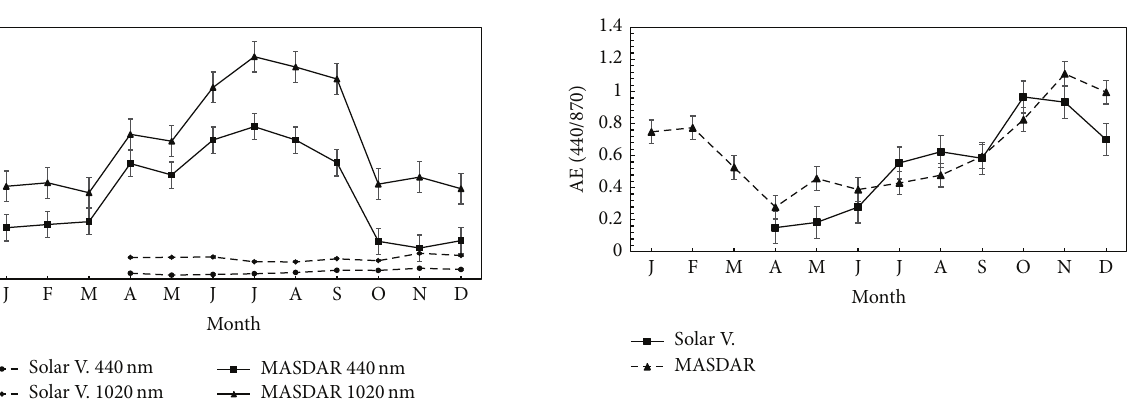
Figure 8: AERONET AE observations using MASDAR from April 2012 to May 2013 using MASDAR station. The vertical bars represent standard